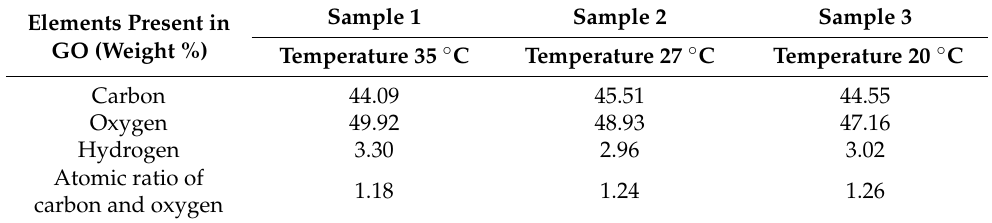
Table 4. Analysis of the elements present in different samples at various temperatures [131].